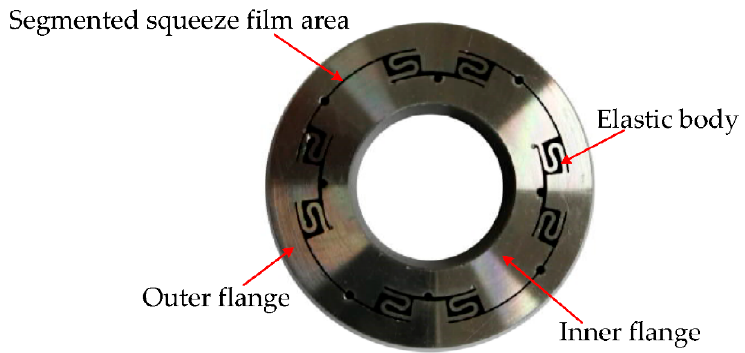
Figure 1. Integral squeeze film bearing damper (ISFBD) structure.